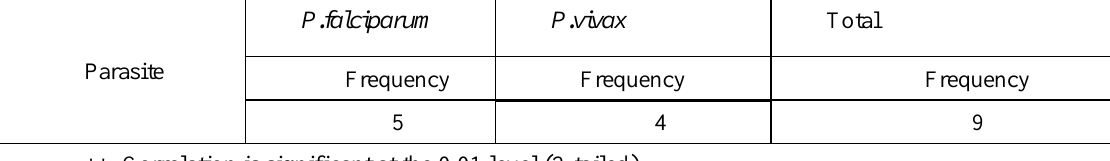
**. Correlation is significant at the 0.01 level